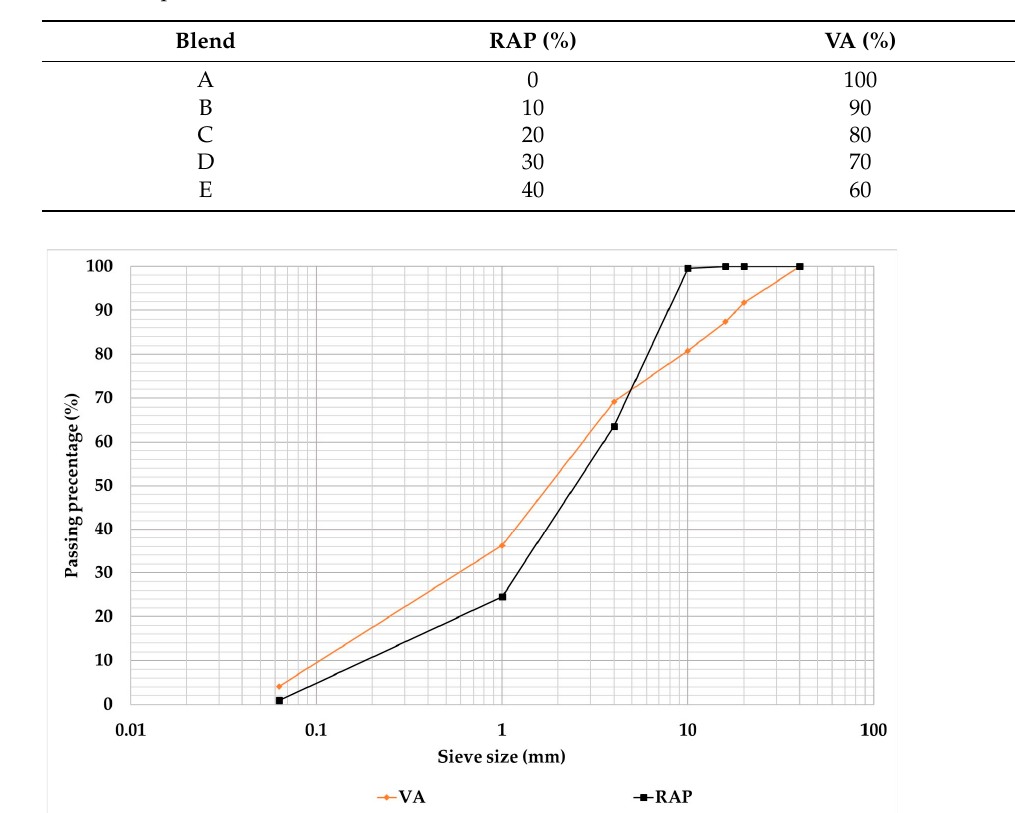
Figure 1. Grain size distribution of VA and RAP.